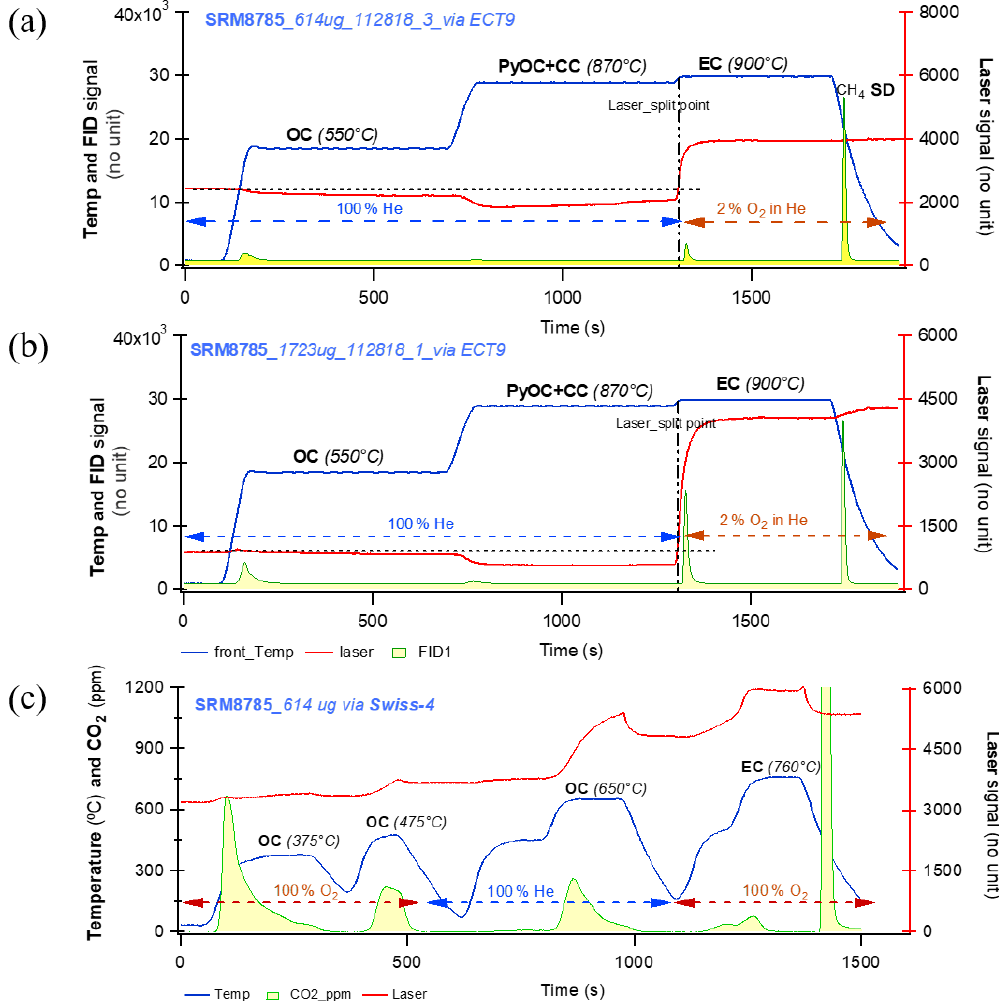
Figure 9. Thermograms of the SRM 8785 filters (the fine fraction (PM 2 . 5 ) of resuspended urban dust particles from SRM 1649a and collected on quartz filters) with various amount of materials ranging from 614 to 1723mg via two different thermal protocols. Panels (a) and (b) were obtained by ECT9. The legends are the same as Fig. 6. Thermograms in (a) and (b) show the similar patterns as in Figs. 6–8 that the laser signals reaching the initial value are just before the temperature stage of EC, suggesting that the charred OC contribution to EC is minimized. The thermogram in (c) is obtained from the same filter in (b) but by Swiss-4 protocol for comparison. The legends are similar except for the integrated area with green line, which stands for CO 2 in parts per million (by non-dispersive infrared) instead of FID